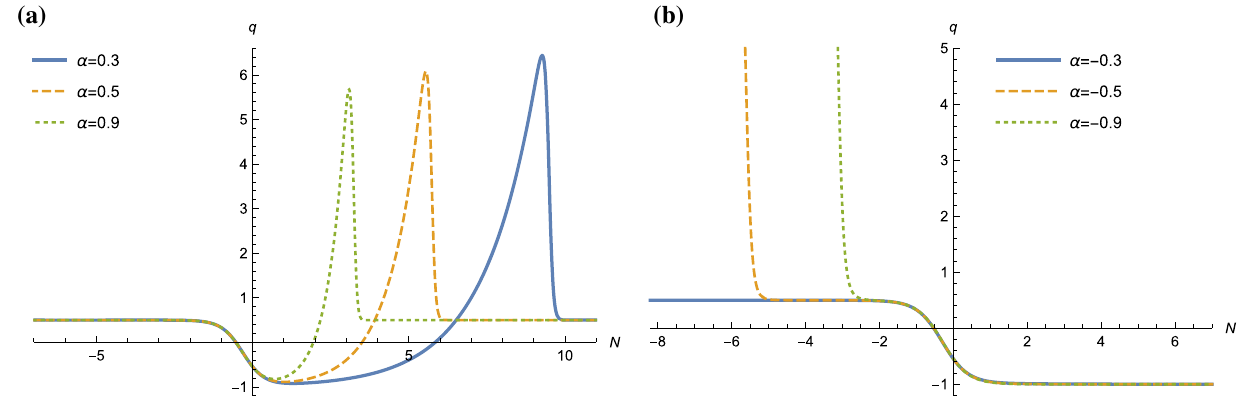
Fig. 3 q is plotted as a function of N . a In Thawing scenario, transient acceleration is inevitable, b freezing quintessence leads the universe into eternal accelerating phase